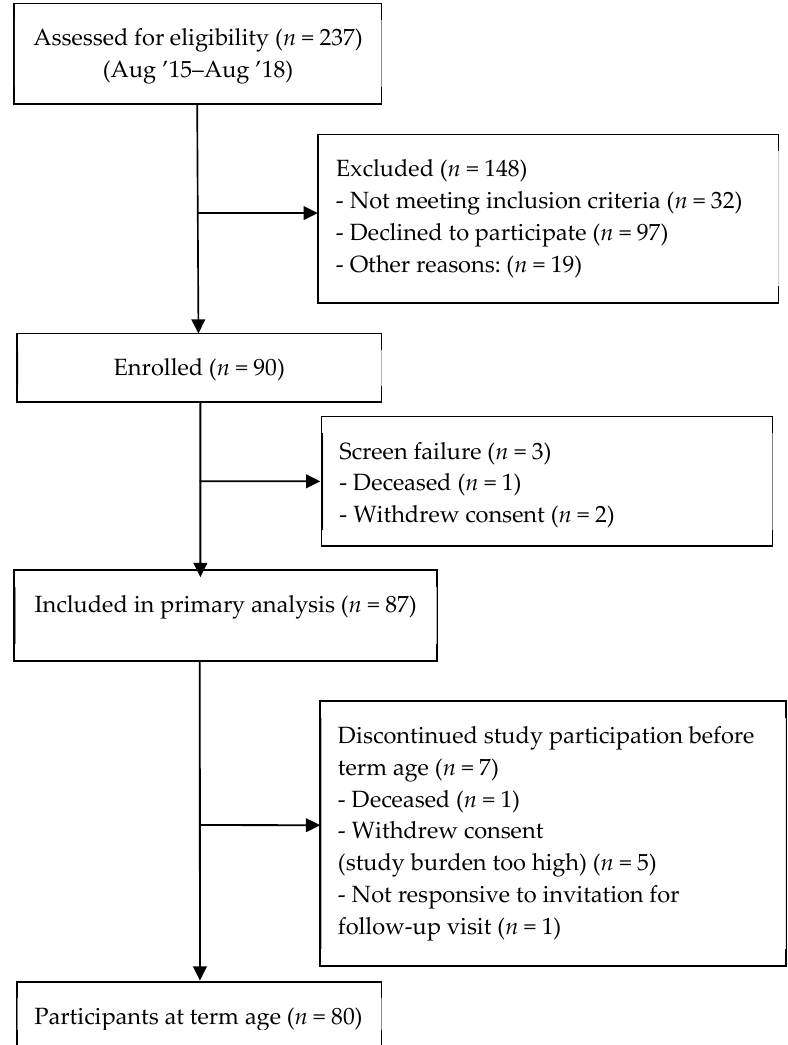
Figure 1. Flow diagram of participants included in the study. Table 3. Characteristics of the study population.